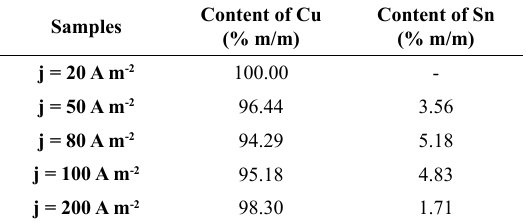
Table 1. Average contents of metals in the Cu-Sn coatings.